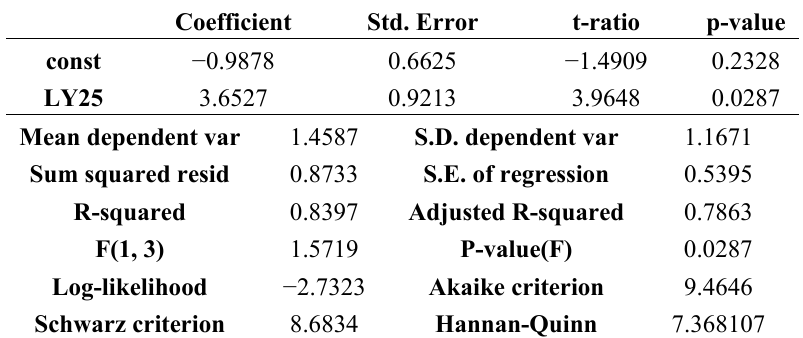
Table 4. LY25 model coefficients and related statistical